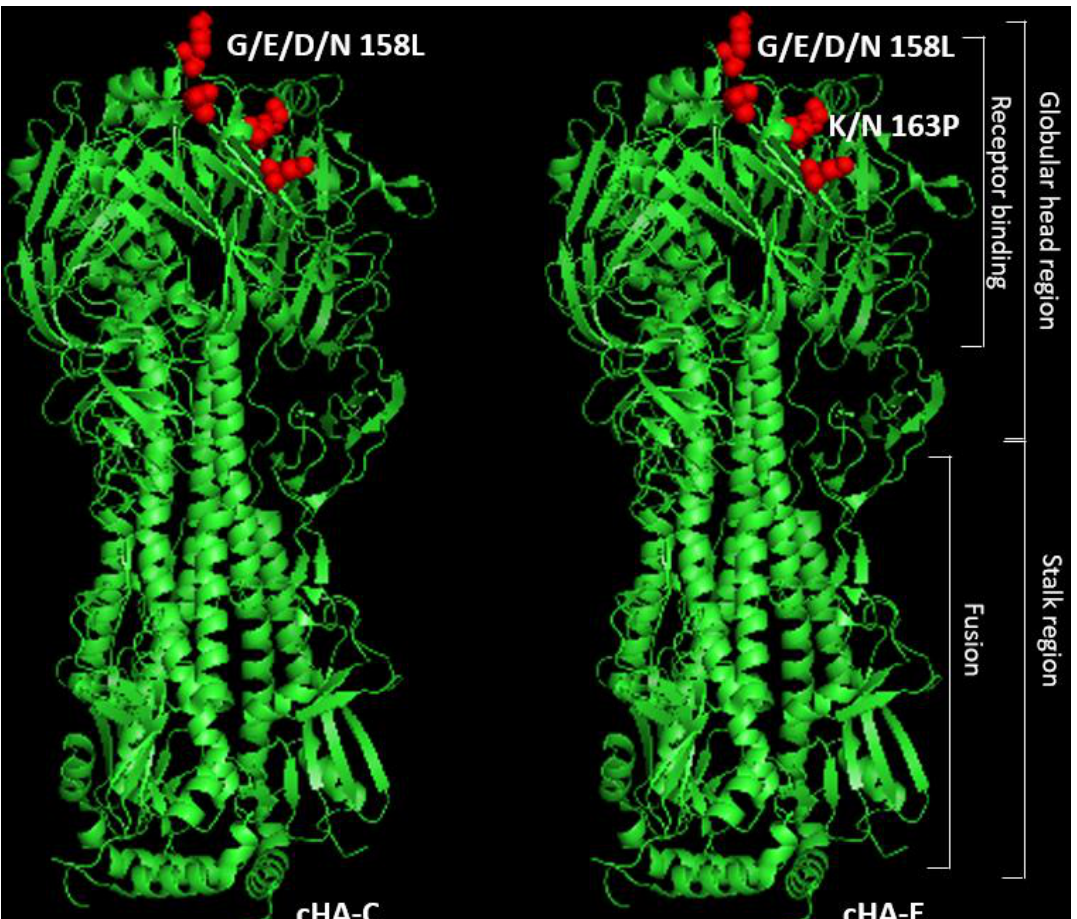
Figure 3. Predicted structures of the in silico synthesized cHAs.